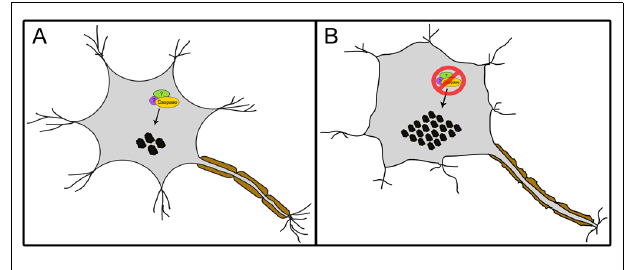
FIGURE 2 |A proposed model of a caspase-dependent mechanism involved in maintaining proteostasis. The interaction of caspases, possibly with yet unidentified additional cofactors, facilitates the regulation of protein aggregates (black circles) within mammalian cells such as neurons (A) .The loss of this mechanism leads to increase in aggregate levels resulting in stress (B)